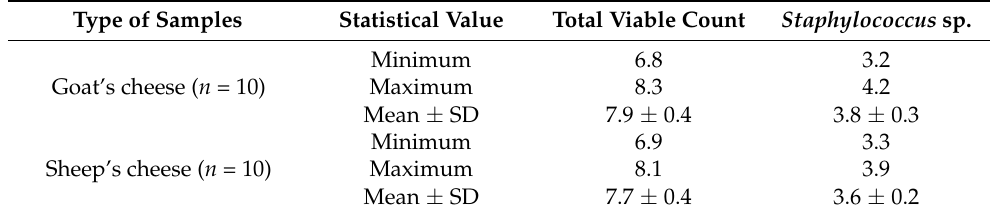
Sheep’s cheese ( n =